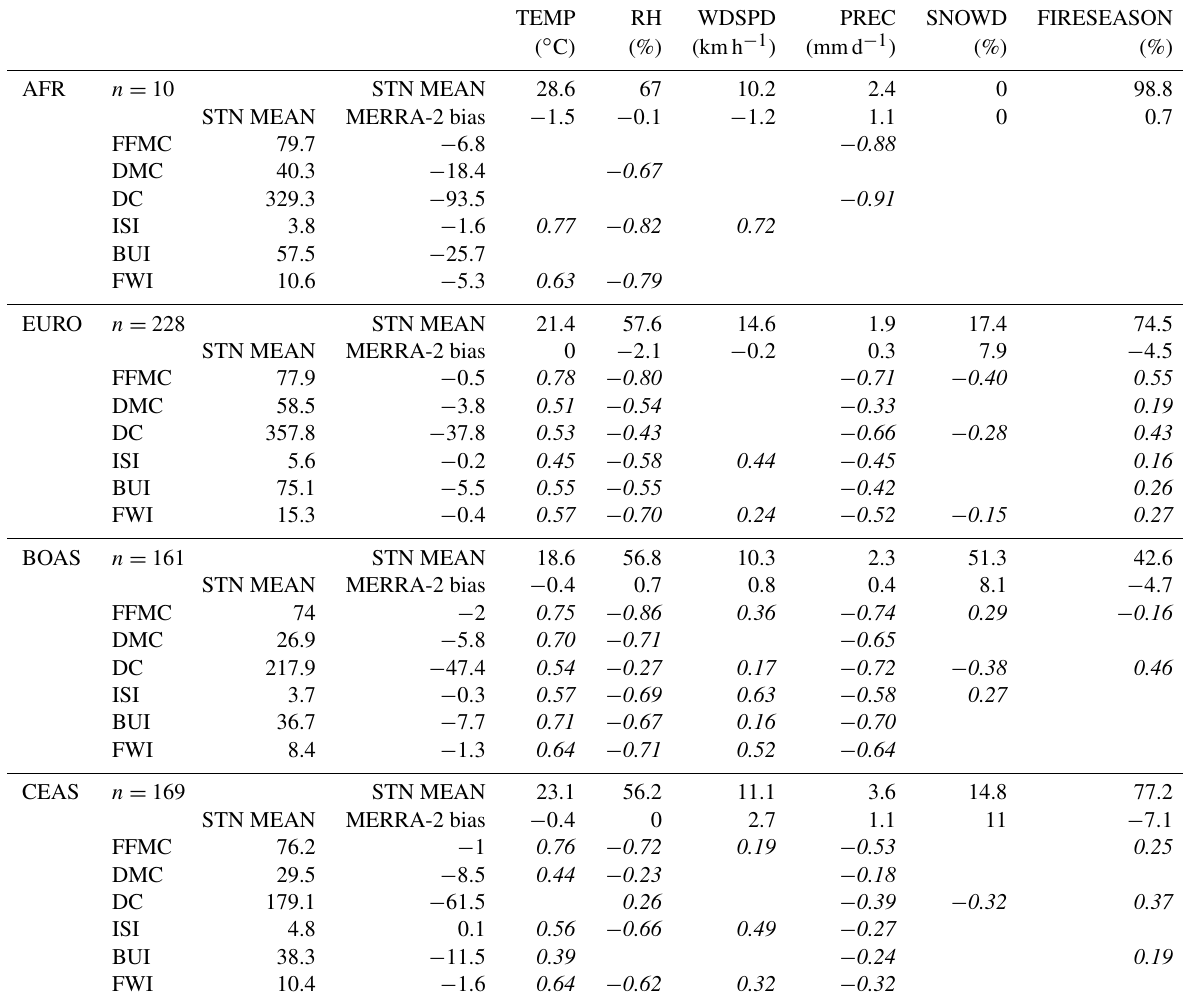
Table 4. Same as Table 2 but for the AFR, EURO, BOAS and CEAS